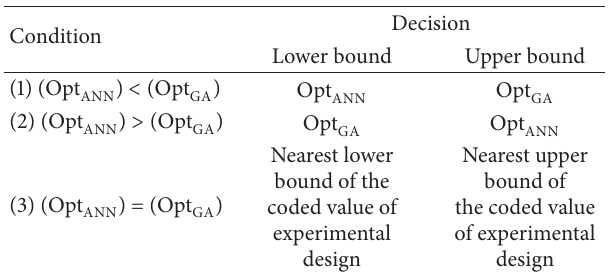
Table 12: Conditions to define limitation constraint bounds of integrated